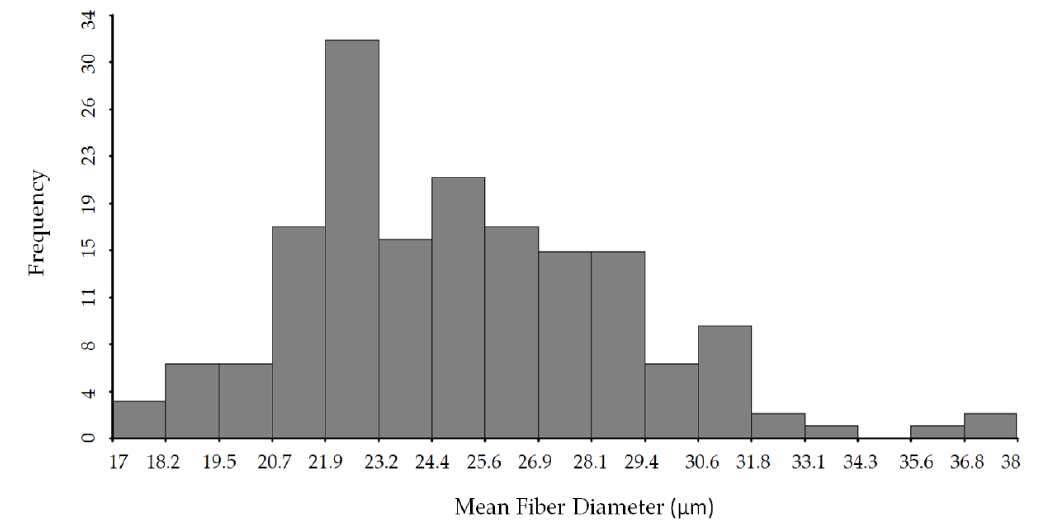
Figure 1. Frequency distribution of MFD values from reference analysis.